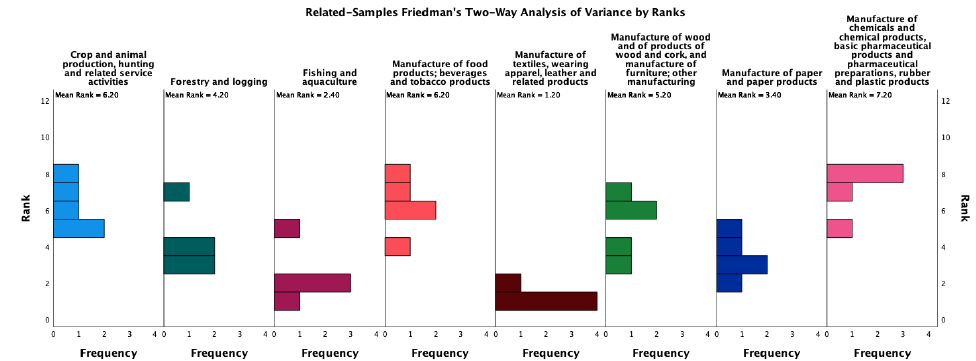
Figure 6. Friedman’s two ‐ way analysis of variance by ranks of Nordic Bioeconomy Sectors